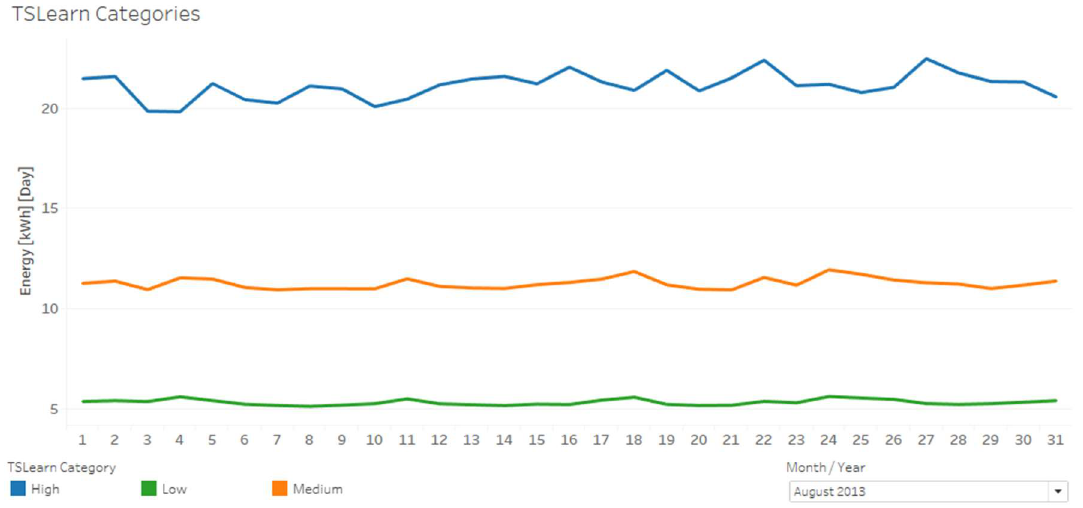
Figure 5. Average energy consumption for each day of August 2013 for each TSlearn category.